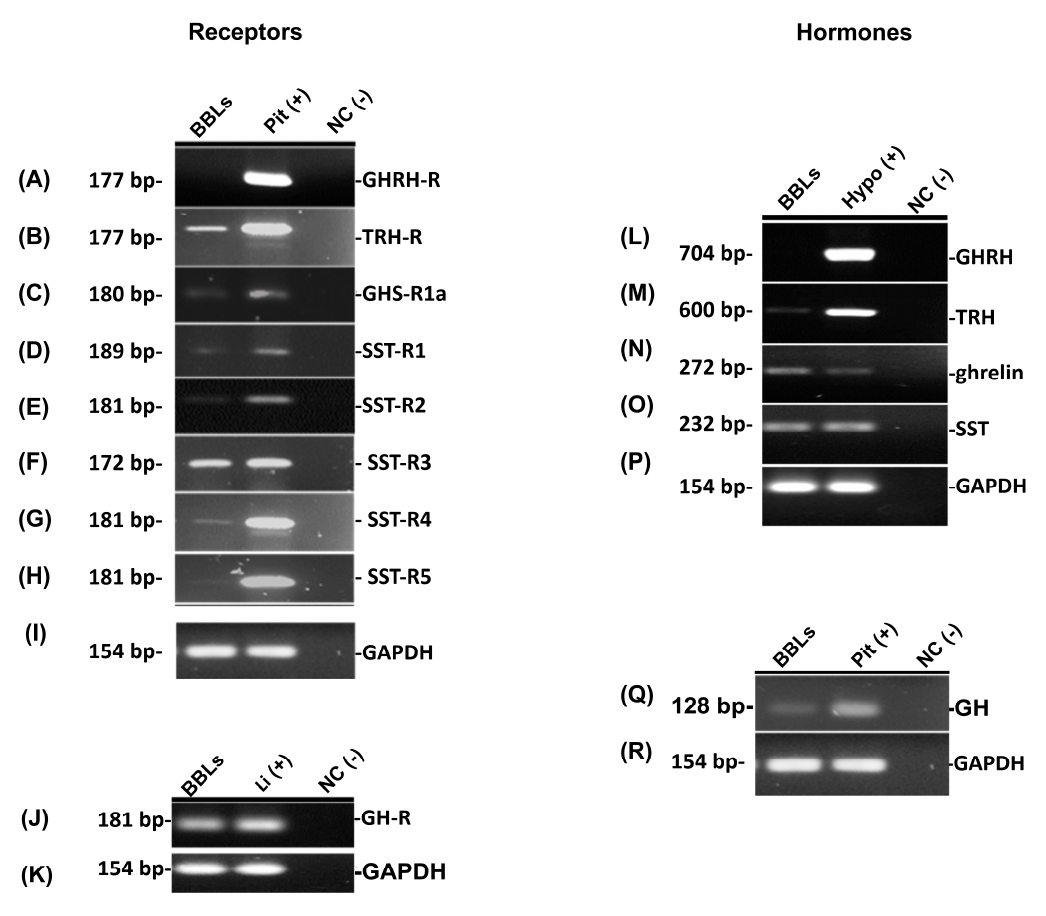
Figure 2. Expression of growth hormone-releasing hormone (GHRH) ( L ) and its receptor, GHRH-R ( A ), thyrotropin-releasing hormone (TRH) ( M ) and TRH-R ( B ), ghrelin ( N ) and GHS-R1a ( C ), SST ( O ) SST-R(1-5) ( D – H ), GH ( Q ) and GH-R ( J ) mRNAs were evaluated in BBLs by RT-PCR and electrophoresis in agarose gels. Pituitary (Pit + ), hypothalamus (Hypo + ) and liver (Li + ) were used as positive controls. GAPDH was used as reference gene in all cases ( I , K , R ). Base pair (bp). Negative controls (in the absence of the corresponding specific template) were included in all cases. Representative figure of 3 independent